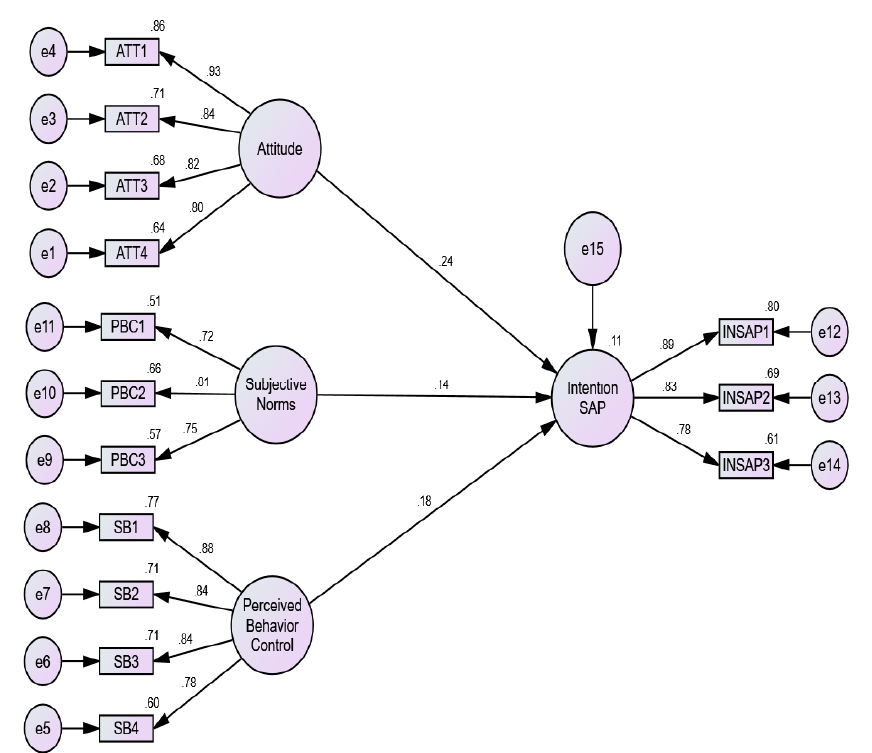
Figure 3. Structural model. Note: ATT = Attitude; SN = Subjective Norms; PBC = Perceived